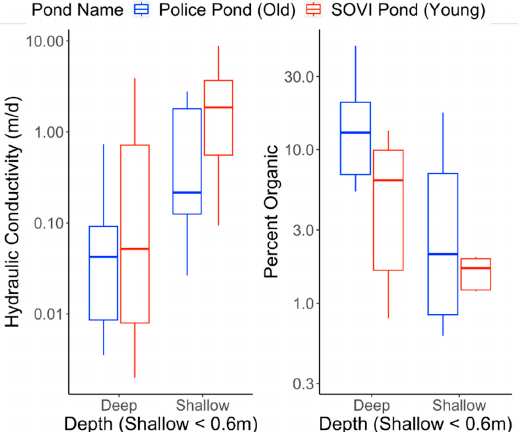
Figure 10. Hydraulic conductivity comparison and organic material between Police Pond constructed in 1996 and SOVI Pond constructed in 2017.